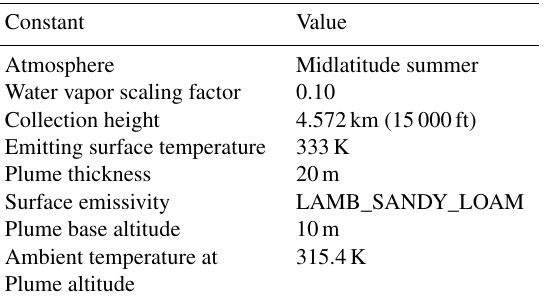
Figure 5. Low-altitude plume model results displaying brightness temperature difference as a function of plume concentration. Fig- ure identifies detectable and undetectable scenarios for MURI’s pre- dicted NEdT. Table 4. Matched-filter and NDMI data set MODTRAN simulation parameter